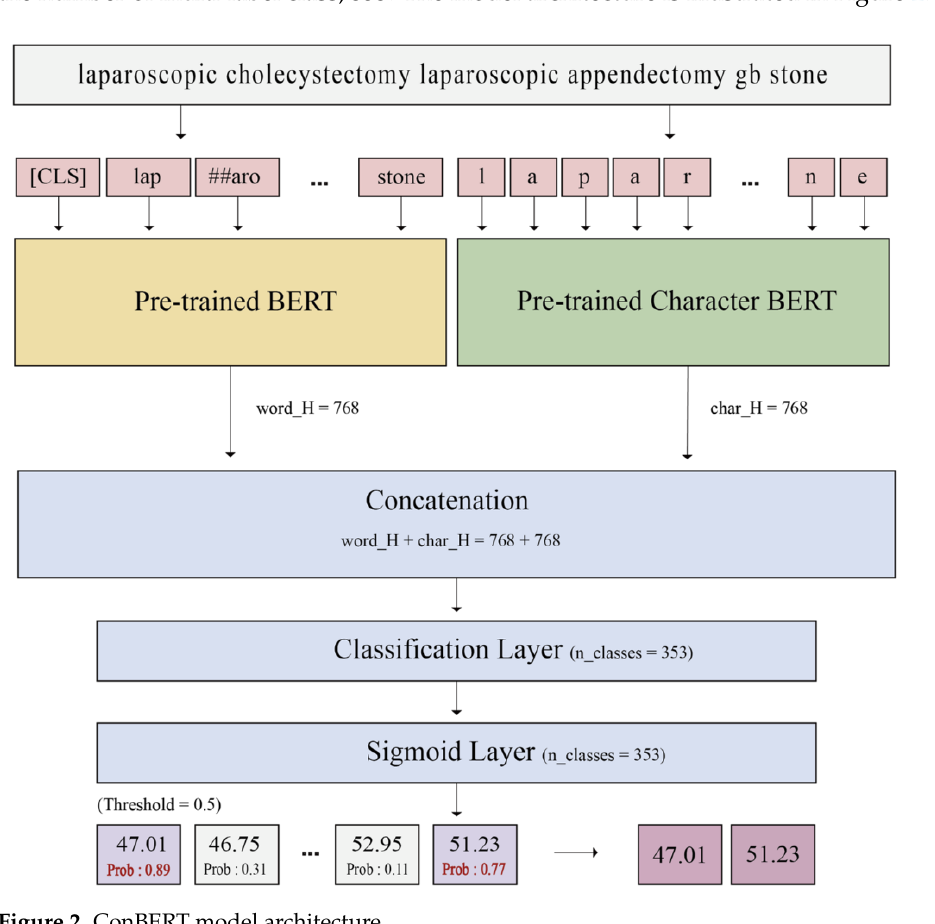
Figure 2. ConBERT model